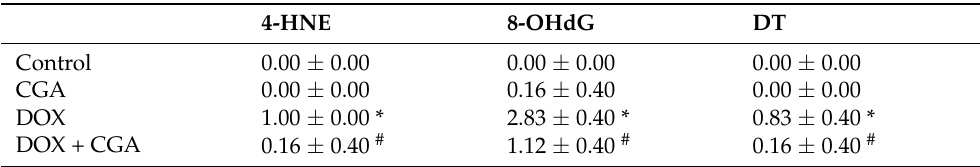
Figure 10. Immunohistochemical staining of DT in experimental groups in cardiac tissue (×400). DT expression levels were significantly elevated in DOX-treated rats while CGA-treated rats demon- strated a significant decline in DT expression. Arrowhead: Intensity of immunoreactivity. ( A ) Control, ( B ) CGA, ( C ) DOX, and ( D ) DOX + CGA. Data are presented as the means ± SD. CGA: Chlorogenic acid (100 mg/kg); DOX: Doxorubicin (15 mg/kg); DT: dityrosine. Table 4. Scoring of immunohistochemical findings. * p < 0.05 vs. the control group, # p < 0.05 vs. the DOX group.